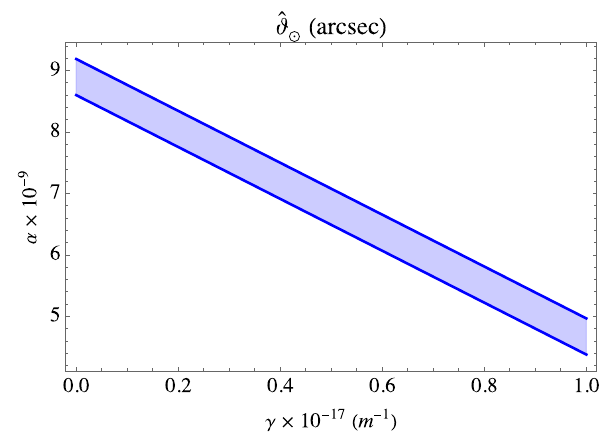
Fig. 2 The confidence range for α and γ , in accordance with the red- shift observed in the GP-A (for the respected values, see Ref. [34])